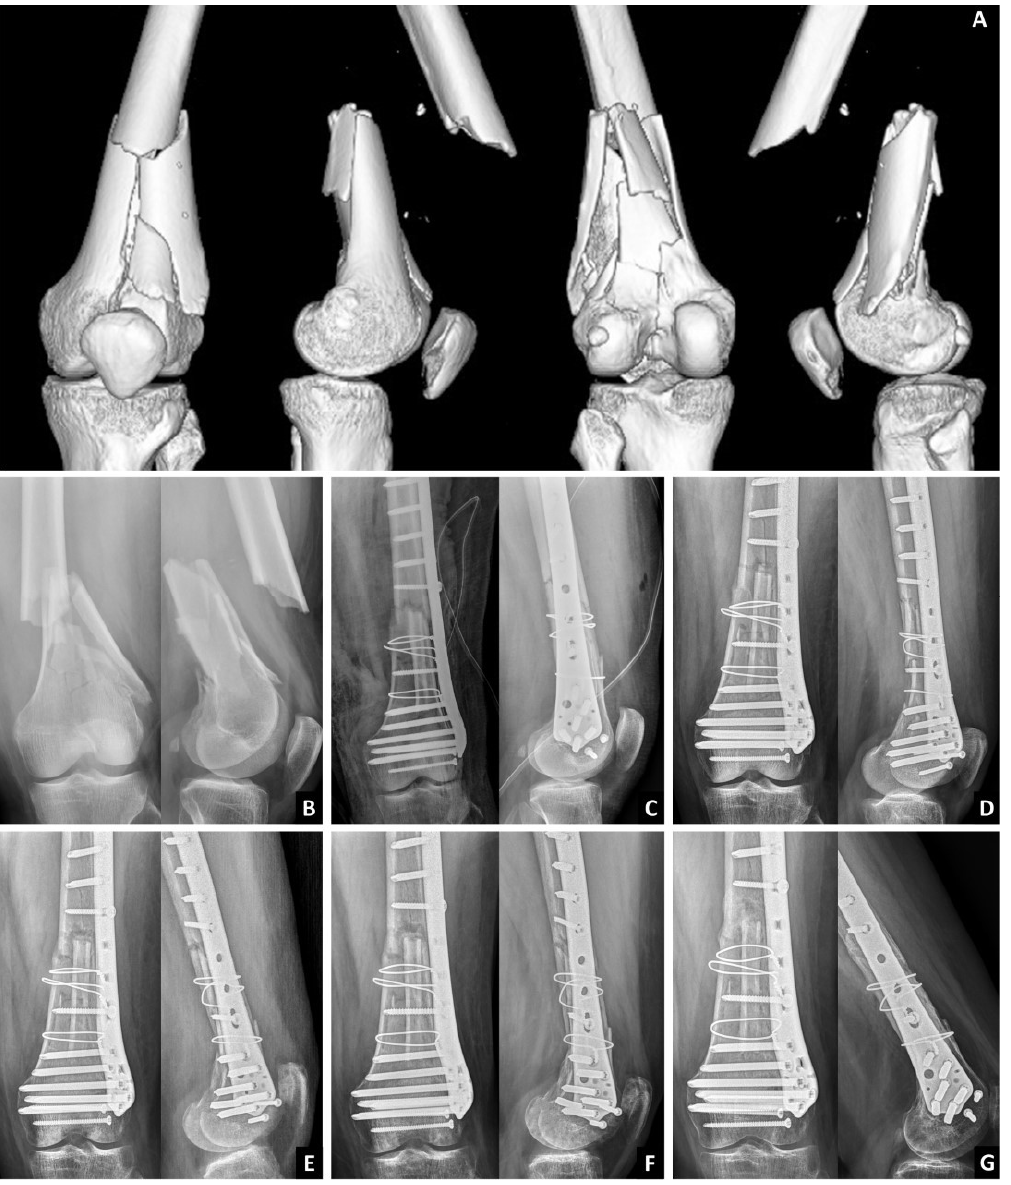
Figure 3. Radiography and computed tomography of the 49-year-old female patient with comminuted distal femoral fracture and good surgical result. ( A ) CT; ( B ) Pre-OP; ( C ) Post-OP; ( D ) Post-OP 1 month; ( E ) Post-OP 3 months; ( F ) Post-OP 6 months; ( G ) Post-OP 1